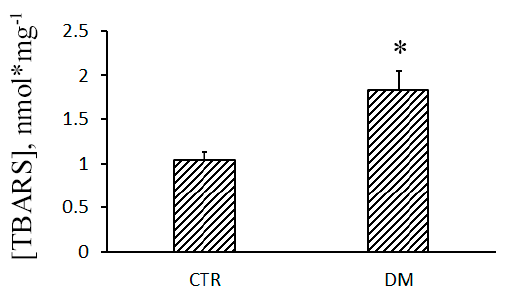
Figure 7. Diabetes stimulates lipid peroxidation in rat liver mitochondria. Lipid peroxidation was assessed by the level of thiobarbituric acid-reactive substances (TBARS) (MDA and other minor aldehyde species) in the liver mitochondria of control (CTR) and STZ-treated (DM) rats. Values are given as means ± SEM ( n = 4). * p < 0.05 compared to controls.